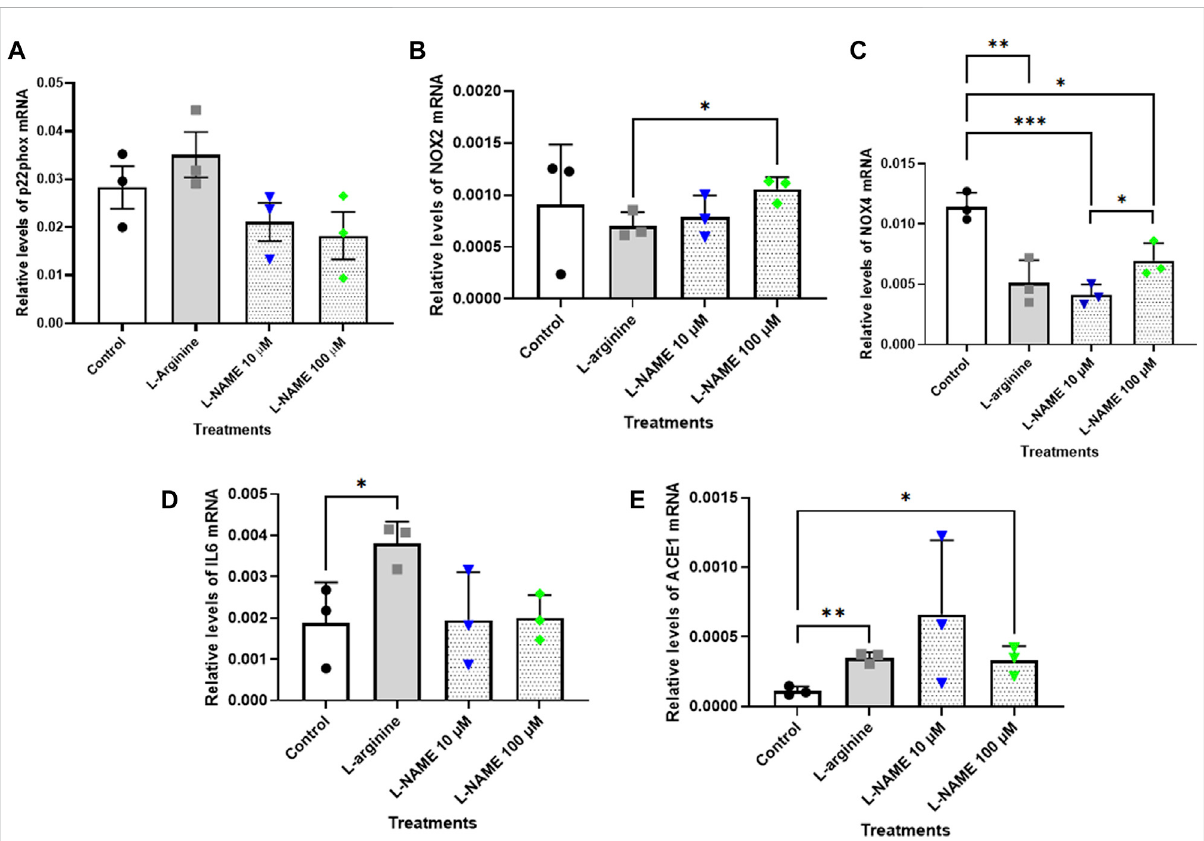
Relative levels of (A) p22 phox , (B) NOX2, (C) NOX4, (D) IL-6 and (E) ACE mRNA in the thymus-derived endothelial cell line tEnd.1 after treatment with L-arginine (100 µM) and L-NAME (10 and 100 µM) for 72 h without retreatment. Data (mean, n = 3) were compared by T Tests. (*Represents statistically signi fi cant difference between groups for p < 0.05; **Represents statistically signi fi cant difference between groups for p < 0.01; ***Represents statistically signi fi cant difference from the control group for p <